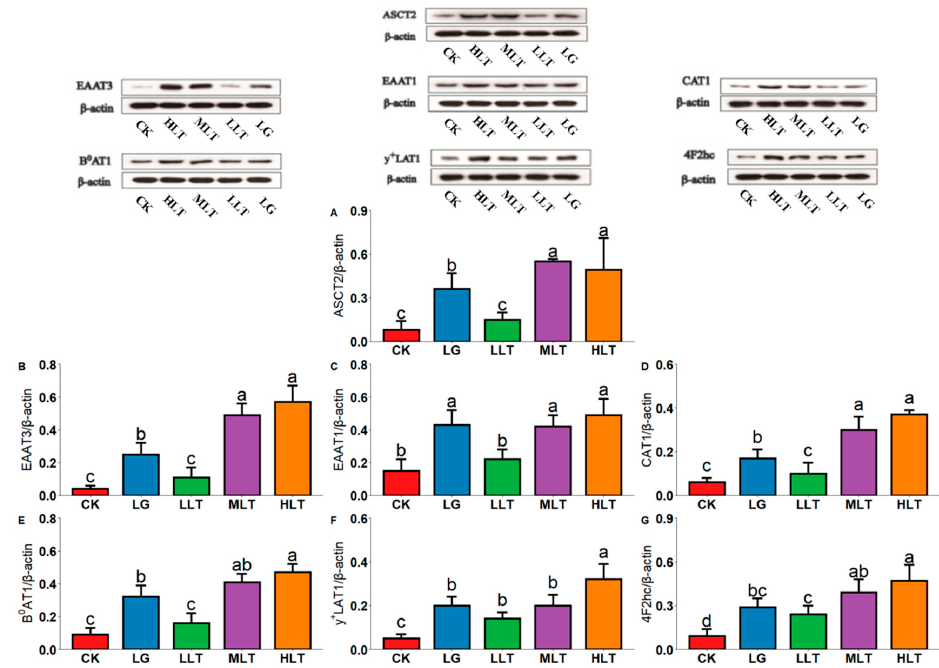
Figure 3. Effects of L-theanine on the protein expression of amino acid transporters of ( A ) ASCT2, ( B ) EAAT3, ( C ) EAAT1, ( D ) CAT1, ( E ) B 0 AT1, ( F ) y + LAT1, and ( G ) 4F2hc in the duodenum of mice. CK (control), HLT (LTA—400 mg•kg − 1 •d − 1 ), MLT (LTA—300 mg•kg − 1 •d − 1 ), LLT (LTA—100 mg•kg − 1 •d − 1 ), and LG (L-glutamine—300 mg•kg − 1 •d − 1 ) groups. Values are presented as mean ± SD; n = 3/group. Different superscript letters in the same figure indicate statistically signifi- cant differences ( p <